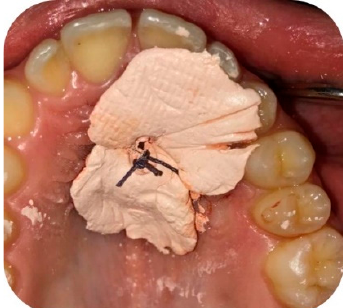
Figure 6. Periodontal dressing application (Coe ‐ Pak) blocked by a suture point in Vicryl 3.0.